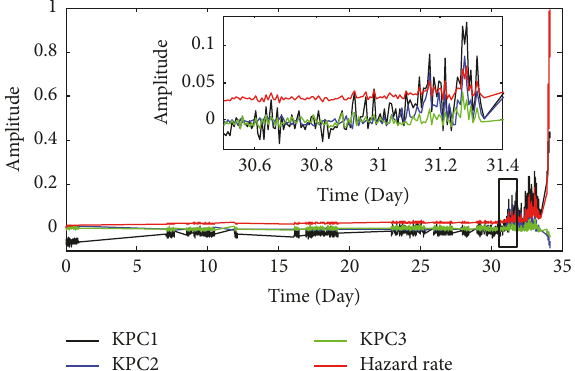
Figure 13: The KPCs and the hazard rate throughout the entire life of the bearing.